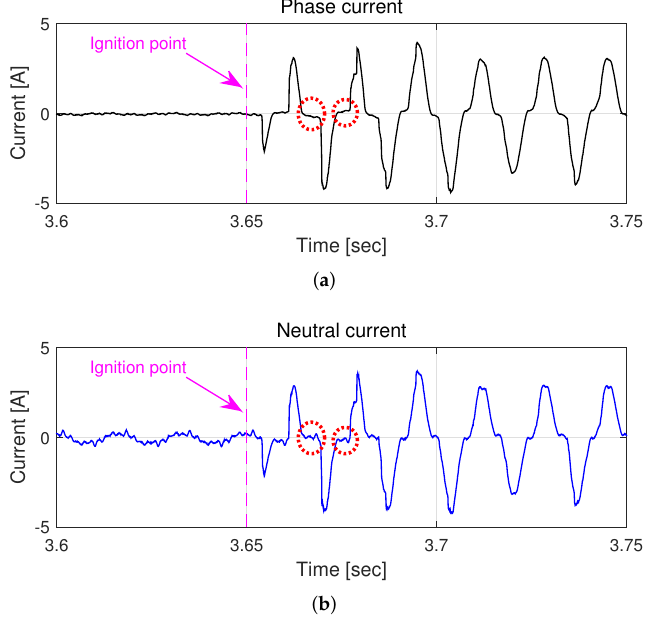
Figure 4. Phase current and neutral current in experiments. ( a ) Phase current. ( b ) Neutral